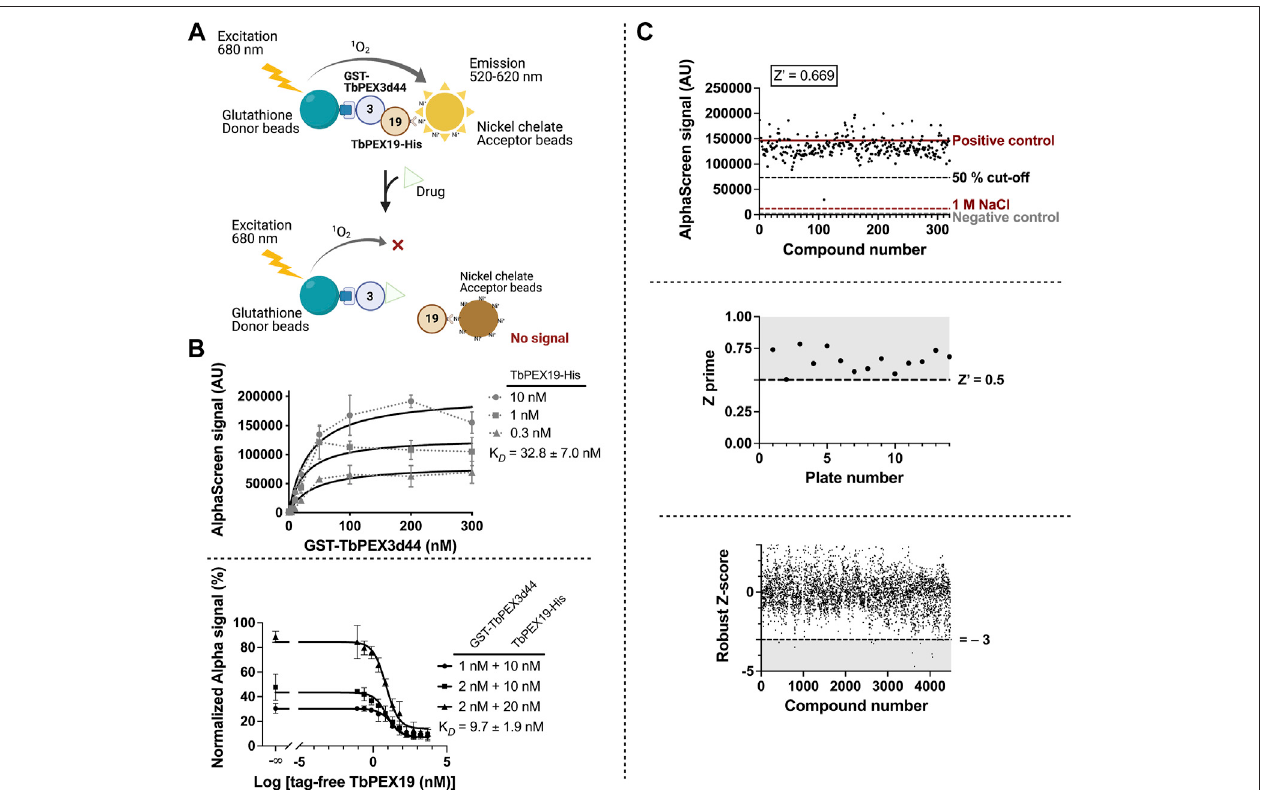
FIGURE 1 | High-throughput TbPEX3 – PEX19 inhibitor screening using AlphaScreen. (A) The screening assay with GST-TbPEX3d44 and TbPEX19FL-His. Interaction of the two proteins leads to different levels of light emission in the absence and presence of inhibitors, which can be quantitatively measured. (B) Binding of GST-TbPEX3d44 and TbPEX19FL-His was analyzed in a saturation assay (upper panel) ; curves were fi tted using one-site speci fi c binding model with GraphPad. TbPEX19 was tested at three concentrations in independent saturation assays with serial dilution of TbPEX3, each of the data points represent the average of triplicates, and standard deviation is shown as vertical bars. An apparent K D of 32.83 ± 7.04 nM was obtained from the three assays. Lower panel shows the binding af fi nitybetweenGST-TbPEX19andTbPEX19-Hisanalyzed bycompetitivebindingassayusingtag-freeTbPEX19. Curveswere fi ttedusingone-sitehomologousmodel which assumes tag-free TbPEX19 binds in the identical way as of TbPEX19-His to GST-TbPEX3d44. An apparent K D of 9.7 ± 1.9 nM was estimated. (C) Compound screeningassayswereperformedin384-wellplateformatandindividualplatescontainedfollowingcontrols:negativecontrolintheabsenceofproteincomplexshowing backgroundsignal;positivecontrolrepresentingnormalproteininteraction,1 MNaClwasusedtocompletelydissociatethecomplex (upperpanel) .Rawreadingsfrom anexampleplatewithoriginalAlphaScreensignalareshownintheupperpanelusinga50%signalcutoff.Zprime valueofeach platewascalculatedtoensuretheassay reliability, with 0.5 ≤ Z ’ ≤ 1 (middle panel) . Hits were selected using robust Z score; compounds giving robust Z score ≤ − 3 were prioritized (lower panel) .